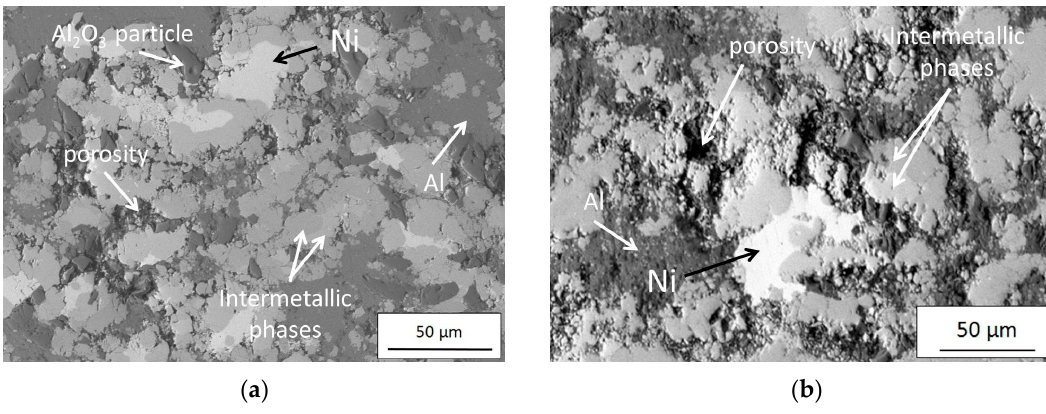
Figure 5. Micrographs (SEM, BSE) of 33% Al coating heated in furnace at 560 °C ( a ) and 620 °C ( b ).